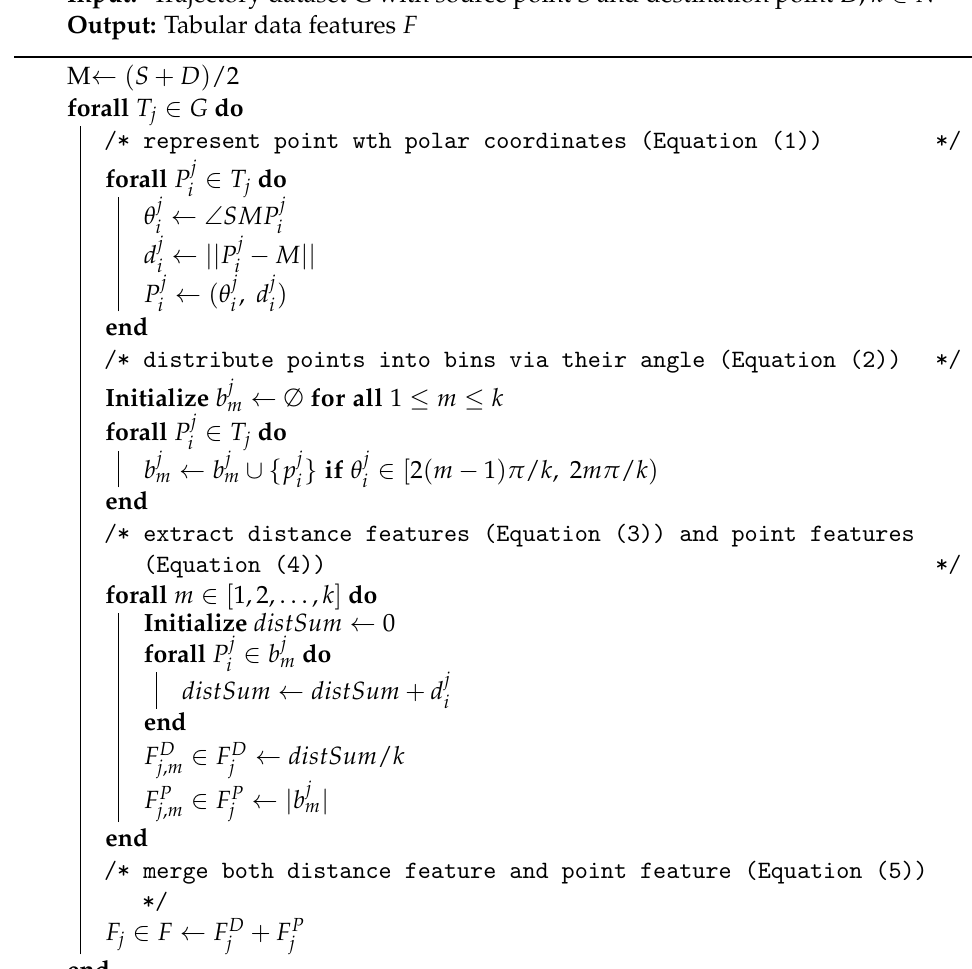
Algorithm 1: General idea of MiPo ( G , k ) → F (Raw idea